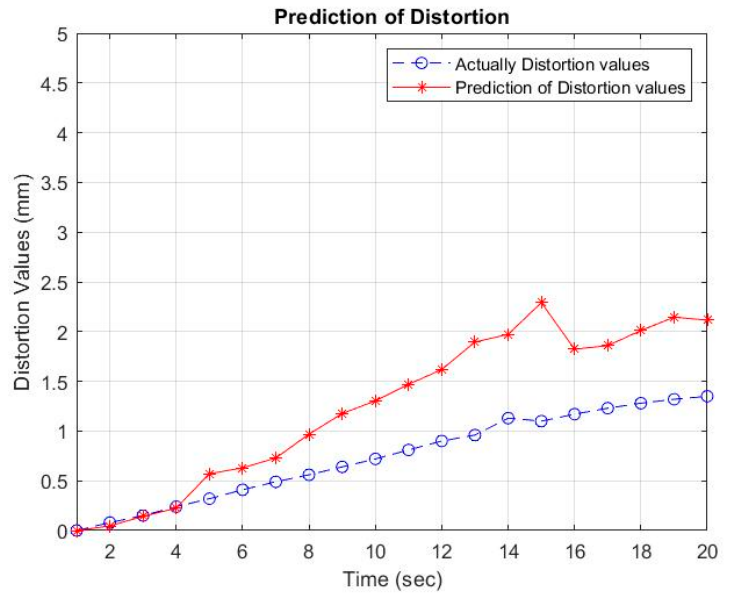
Figure 7. Comparison of predictions and experiments of distortion values at an electrode distance of 27 mm.